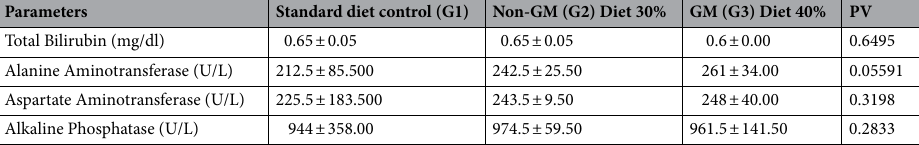
Table 1. Liver function tests.